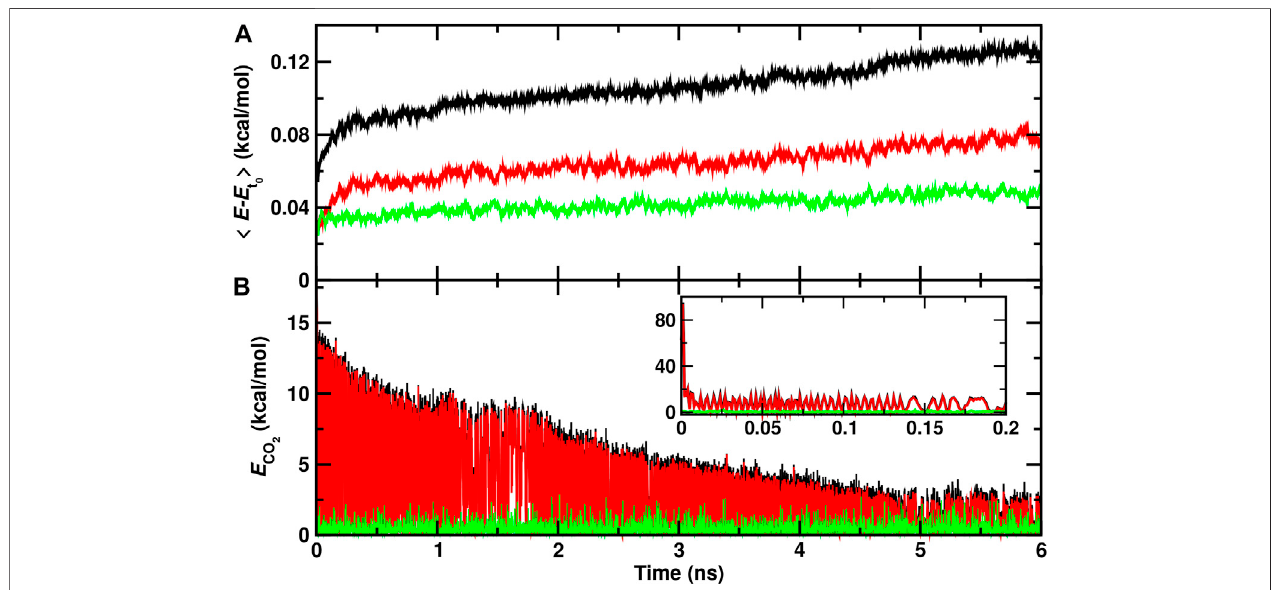
FIGURE 4 | Total (black), internal (red), and translational (green) energies for water molecules (A) and for the recombined CO 2 molecule (B) form a 6 ns rebinding trajectory on the top of the ASW surface. The time of reaction is shifted to t (cid:2) 0 and de fi ned by the fi rst instance at which r C − O energy in the ASW further increases beyond the maximum simulation time of 6 ns after CO 2